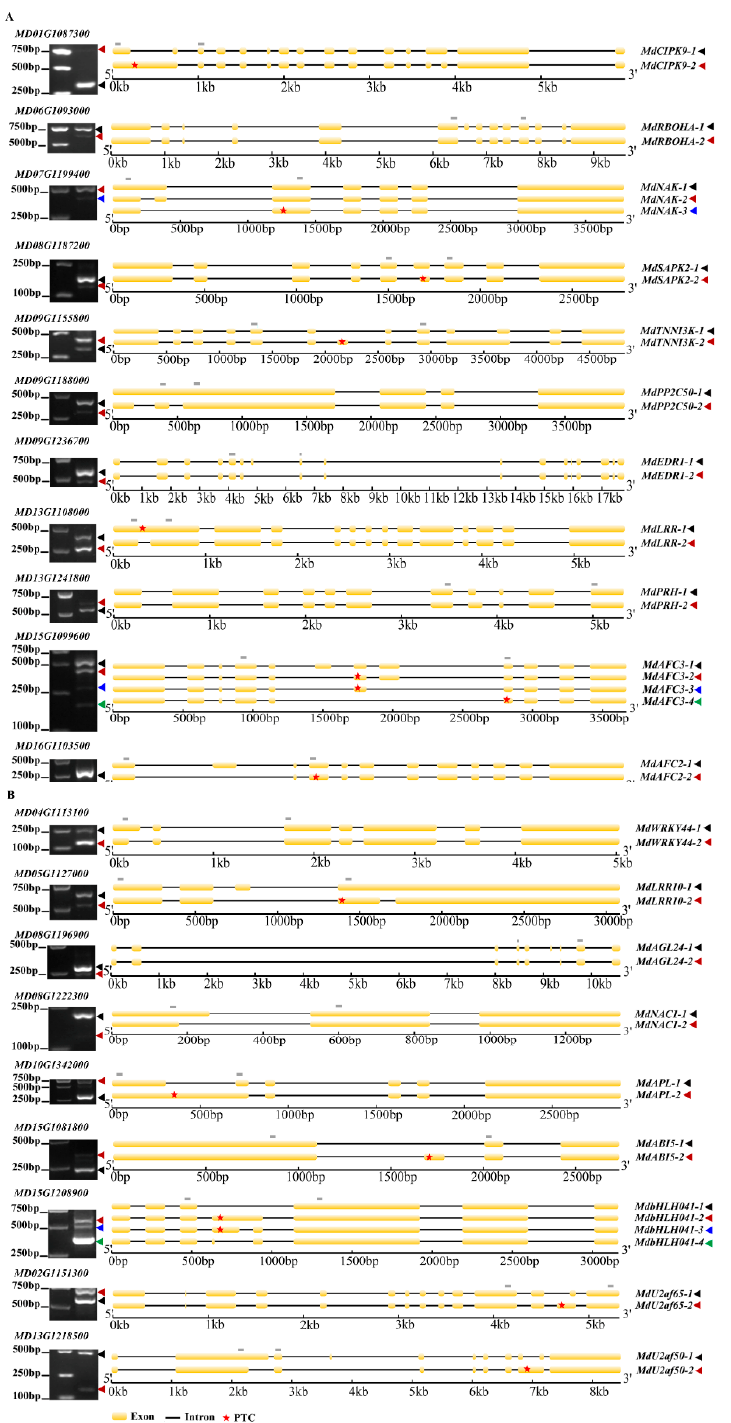
Figure 6. Validation of AS events by RT-PCR in response to A. alternata AP infection in apple. ( A ) The AS events in eleven functionally characterized genes. ( B ) The AS events in nine transcription factor and splicing factor genes. The locations of RT-PCR primers were marked with gray rectangles. The annotated and novel transcripts were marked with black and other colored arrowheads, respectively. The positions of PTCs were marked with red asterisks.